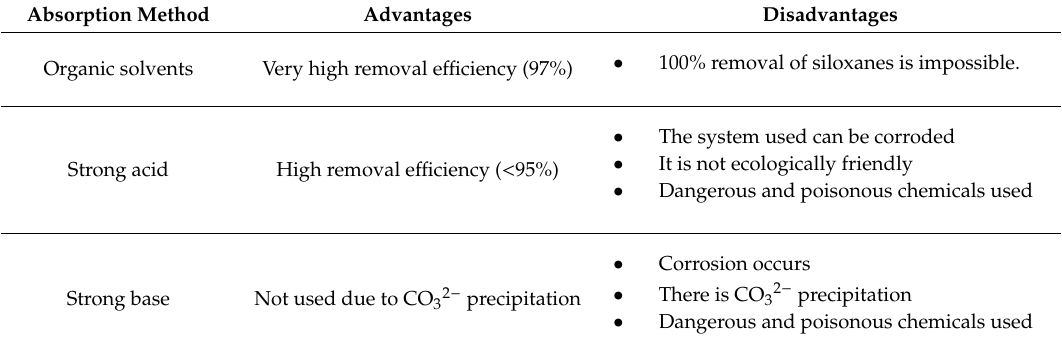
Table 4. Advantages and disadvantages of absorption methods